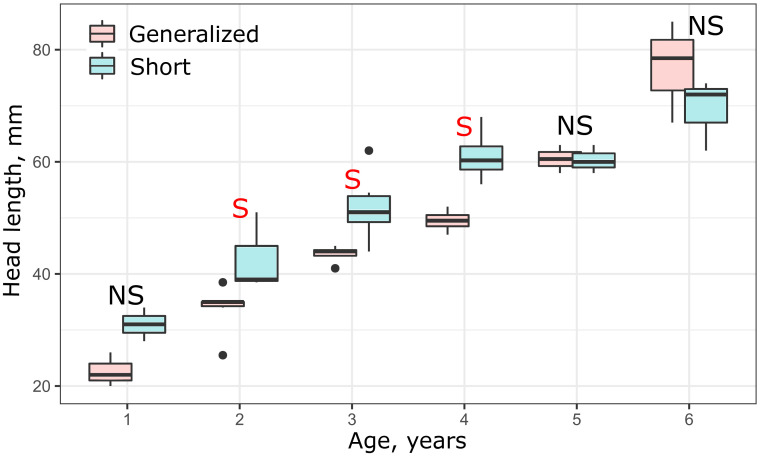
Age vs head length in generalized (GN) and short (SH) morphs in 2009.Median is shown as the horizontal black line inside the box. The box represents 1st and 3rd quartiles of variation. Letters above each boxplot designate significant (red S), or non-significant (black NS) differences between morphs within each year class, based on Mann-Whitney U tests (p < 0.05).